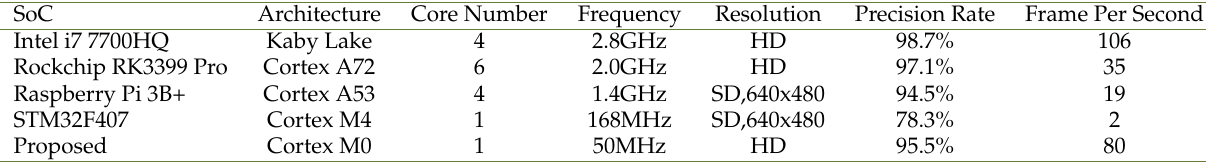
Table 7. Acceleration performance